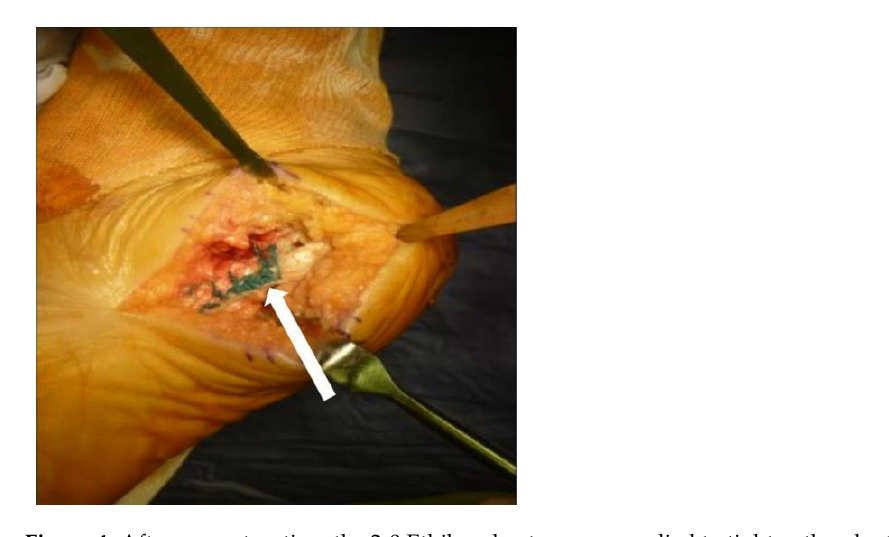
Figure 4. After reconstruction, the 2-0 Ethibond suture was applied to tighten the plantar fascia, as indicated by the white arrow.